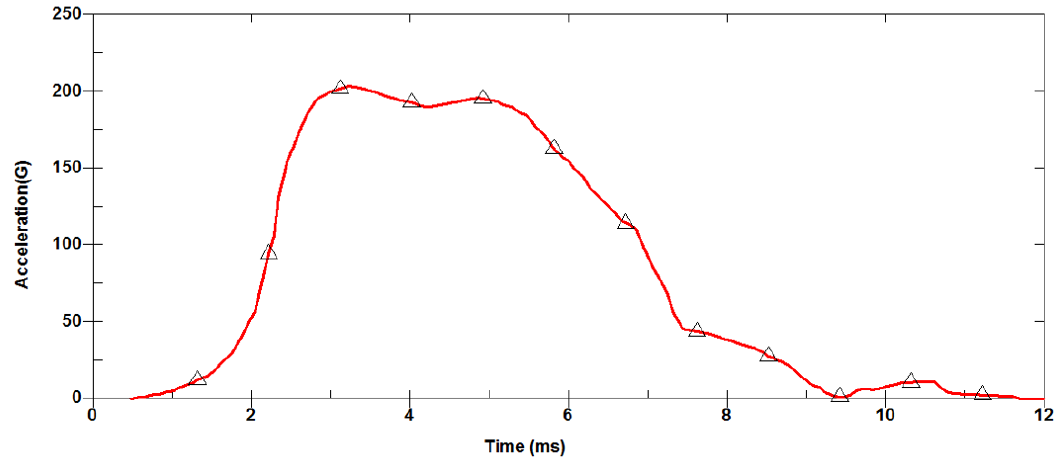
Figure 6. Experimental results for impact energy dissipation in the full-face helmet impact test.